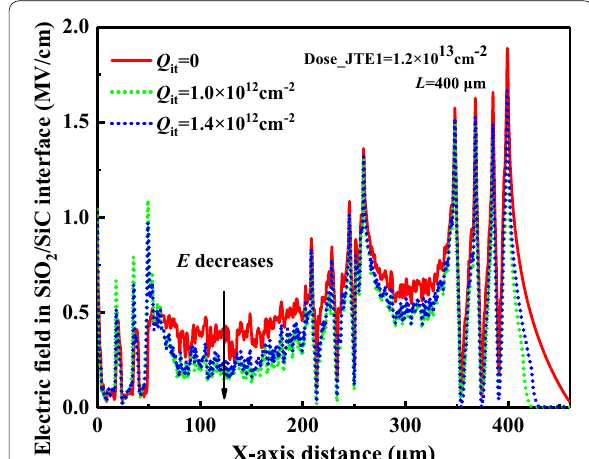
Fig. 6 Surface electric field distributions in breakdown corresponding to different terminal lengths